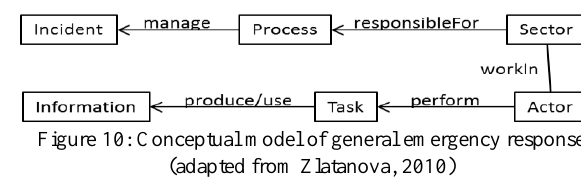
Figure 8. Key dependencies between sectors (adapted from van Dongen et al., 2013)